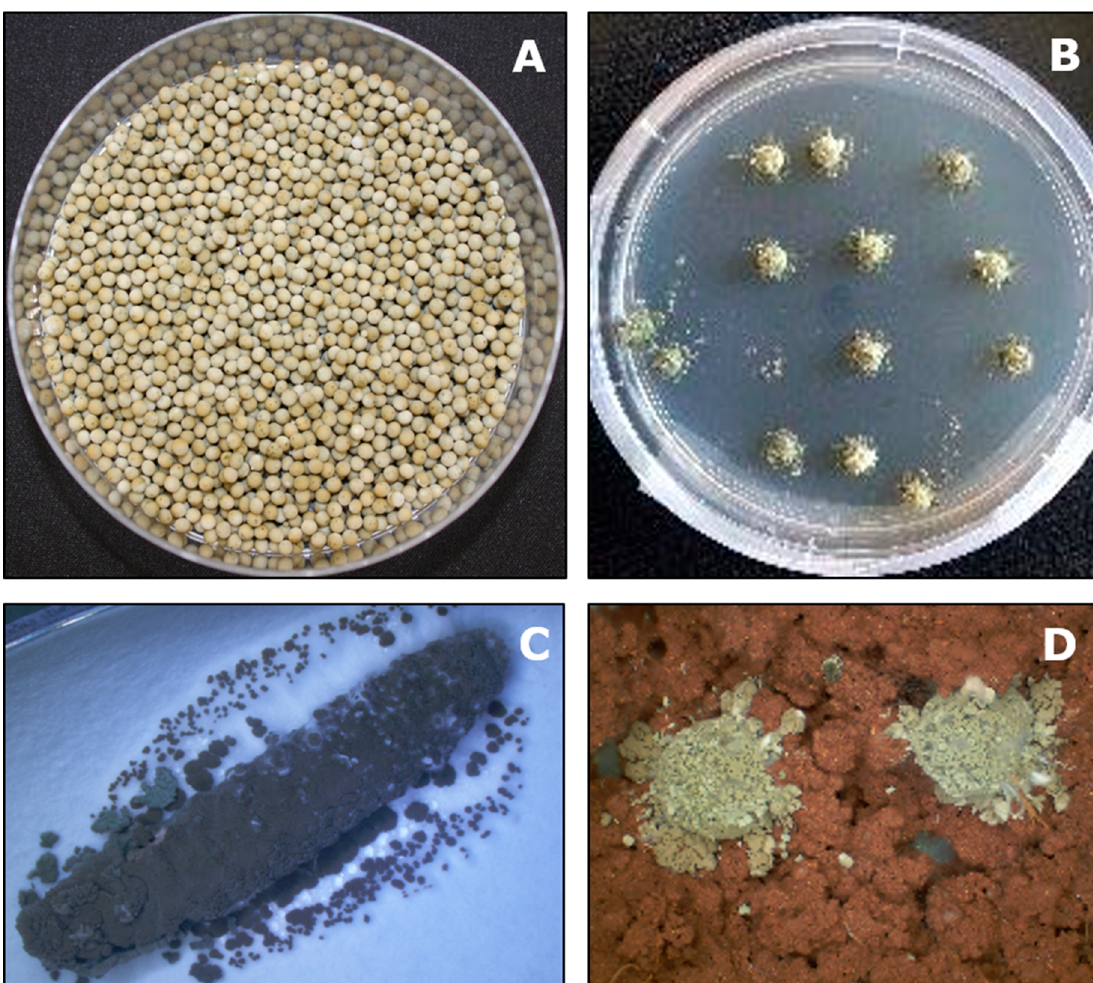
Figure 1. Metarhizium anisopliae formulated in calcium alginate granules (CAG Ma+Cs+By ) for soil insect control ( A ); the fungal granule CAG Ma+Cs+By containing corn starch and autoclaved baker’s yeast as the food source for M. anisopliae produced the optimal resporulation ( B ); a conidiated cadaver (mealworm) caused by the infection of resporulated CAG Ma+Cs+By ( C ); and CAG Ma+Cs+By resporulated in pasteurised soil following one month of incubation ( D ). (Photos source: Sudhan